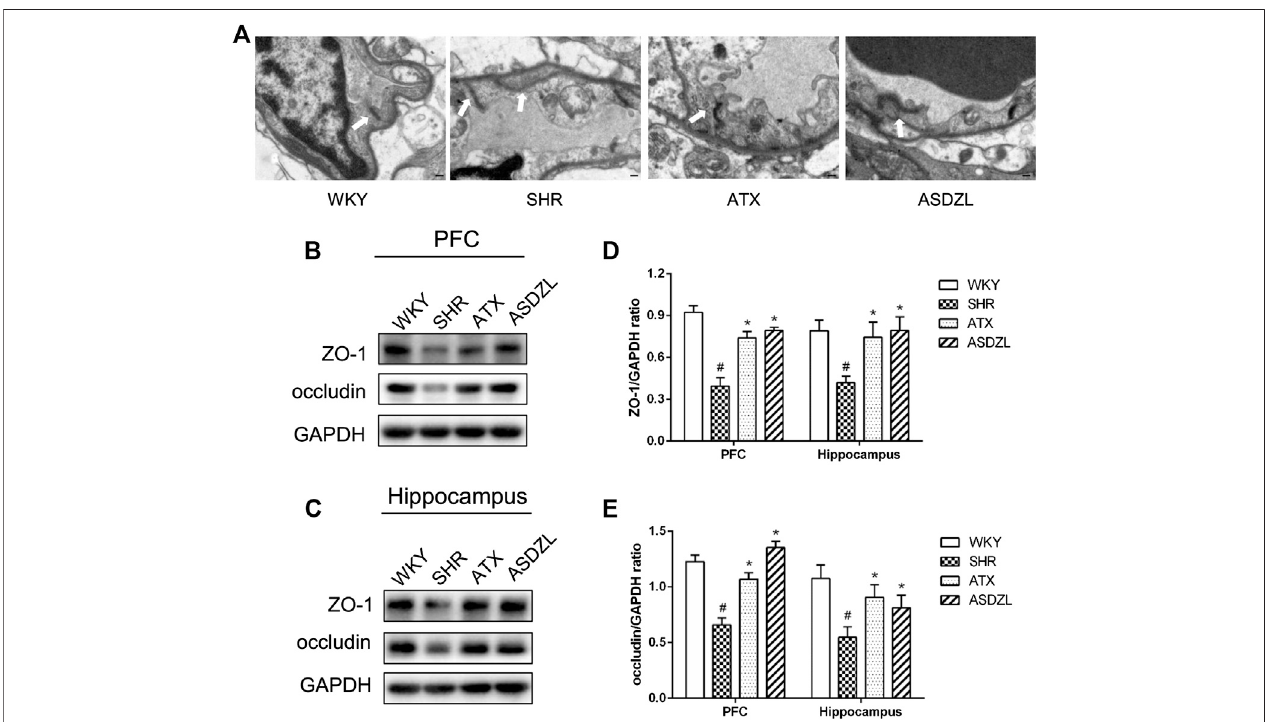
FIGURE 5 | Effect of ASDZL on the BBB. (A) Typical images of the TJs examined by electron microscopy (EM), and the arrows point to the TJs; (B) Western blot analysis of ZO-1 and occludin levels in PFC; (C) Western blot analysis of ZO-1 and occludin levels in hippocampus; (D) , (E) Relative levels of ZO-1 and occludin in PFC and hippocampus (fold change relative to GAPDH level). Data are expressed as the mean ± SD, n (cid:2) 3 for each group. *p < 0.05, SHR vs. WKY group; # p < 0.05, compared to SHR group. Scale bar is 1.0 μ